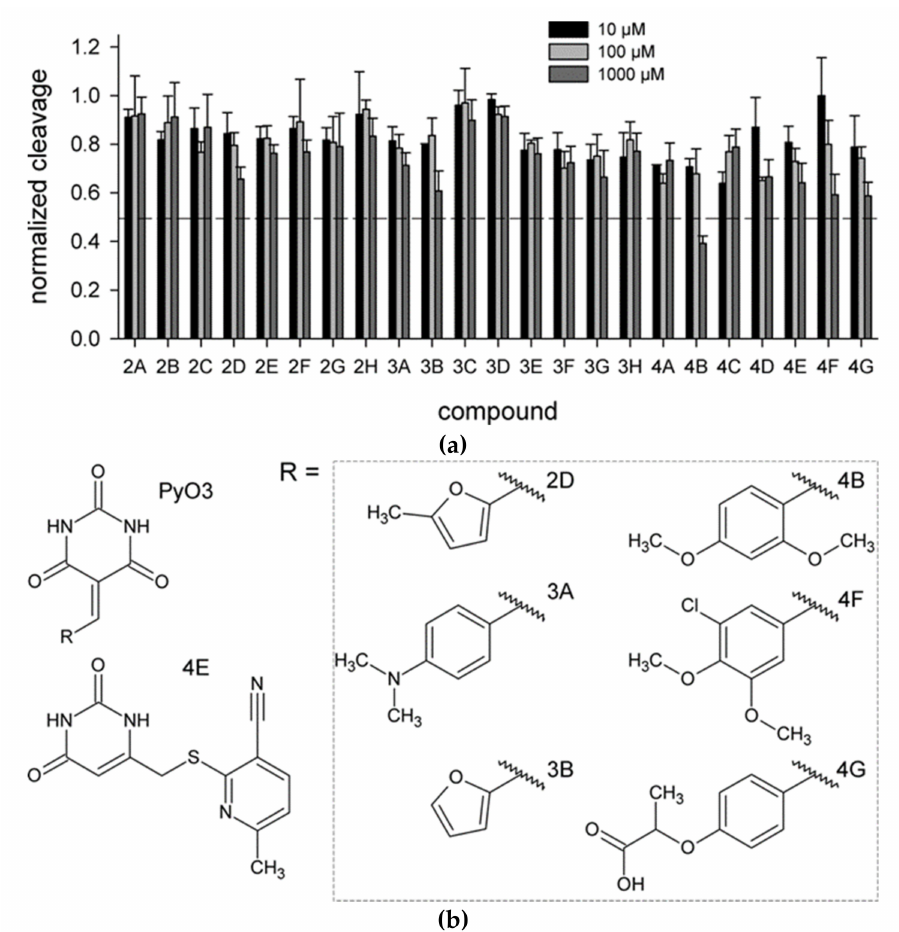
Figure 2. Biochemical screening of the inhibitors identified by molecular docking. ( a ) hUNG activity in the presence of the inhibitors at 10 µ M (black bars), 100 µ M (light gray bars), or 1000 µ M (dark gray bars). The activity is normalized for that in the absence of the inhibitor. Means and SD of three independent experiments are shown; ( b ) Structures of the compounds 2D, 3A, 3B, 4B, 4E, 4F, and